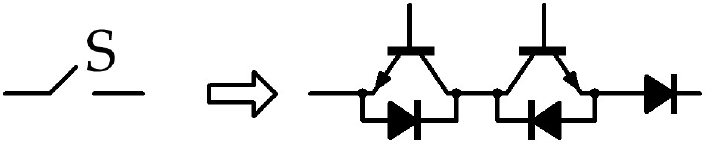
Figure 3. Switch equivalent circuit.